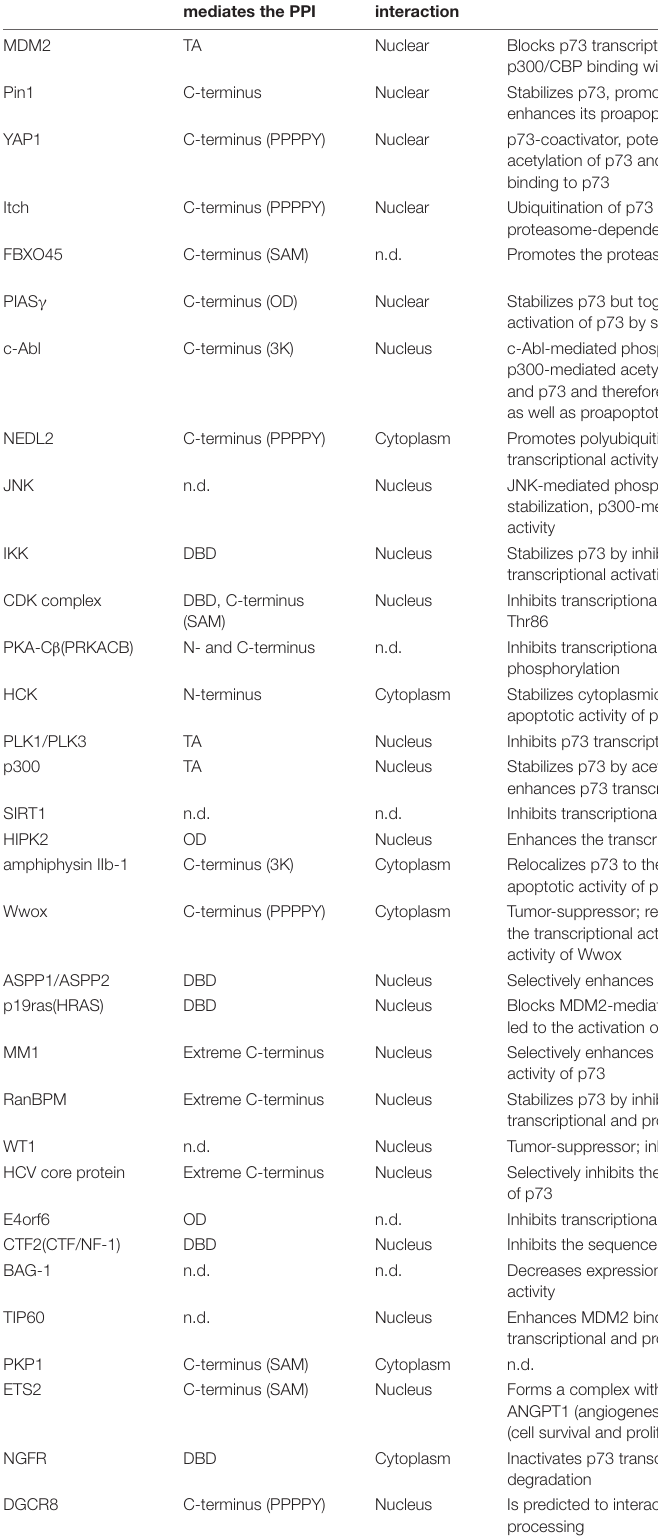
TABLE 1 | Interacting partners of p73 isoforms and their outcome on p73 function. Protein interactor P73 domain that mediates the